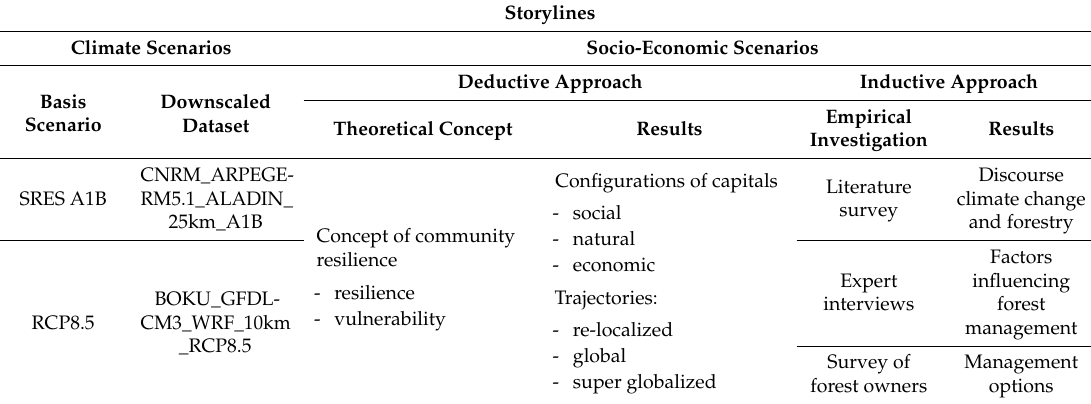
Table 1. Methodological approach for creating the storylines. SRES—Special Report on Emission Scenarios; RCP—representative concentration